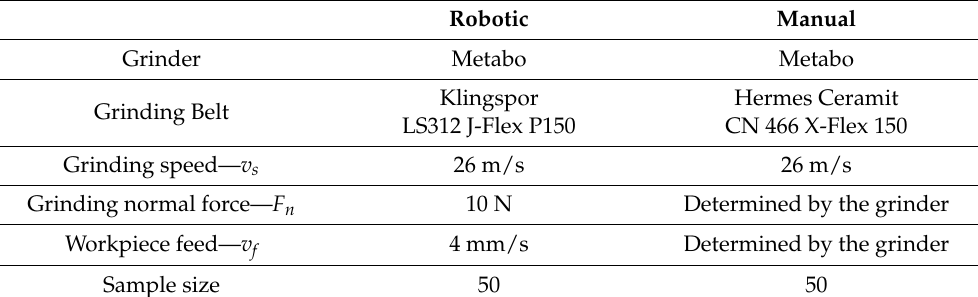
Table 6. Grinding parameters used in comparative research.